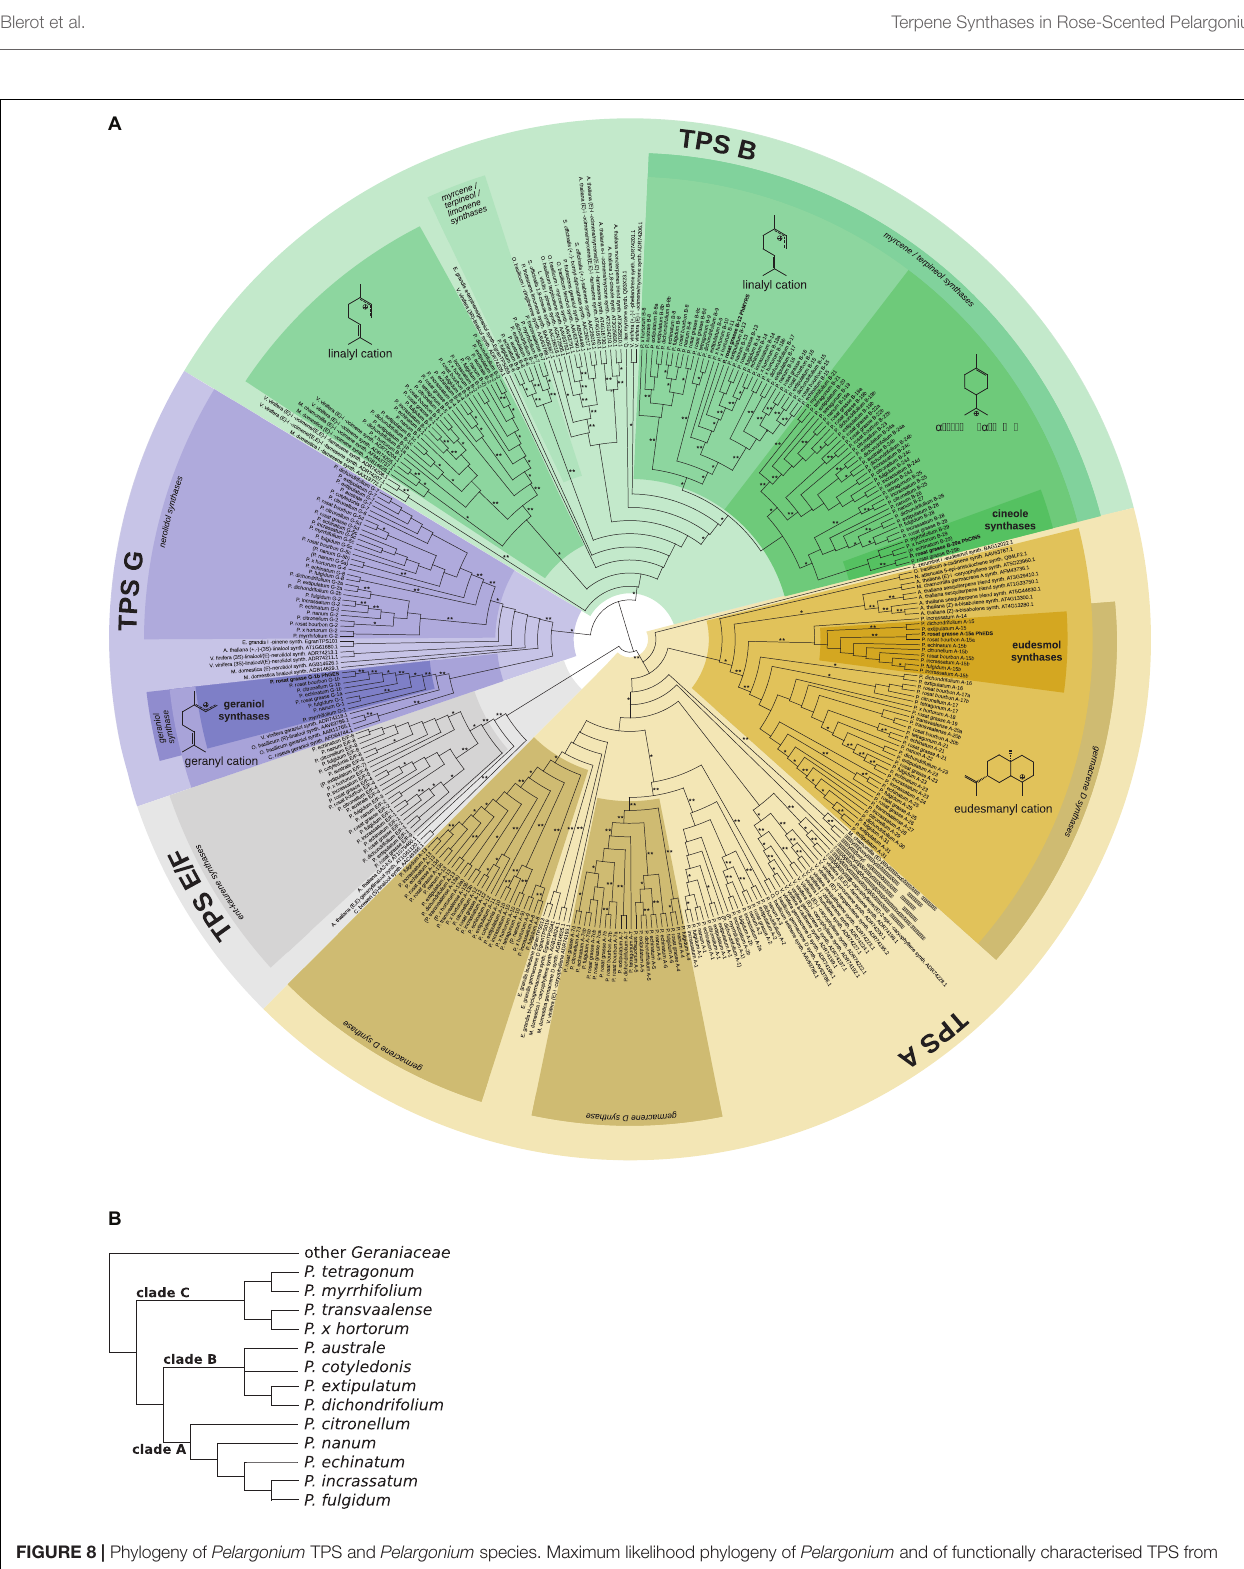
Frontiers in Plant Science |